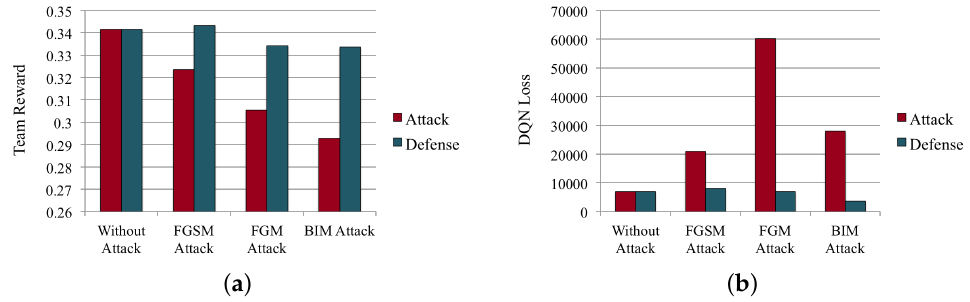
Figure 15. Team reward and DQN loss before and after using defense Algorithm 1 against various adversarial attacks, during 30,000 time steps. ( a ) Team reward before and after defense Algorithm 1. ( b ) DQN loss before and after defense Algorithm 1.